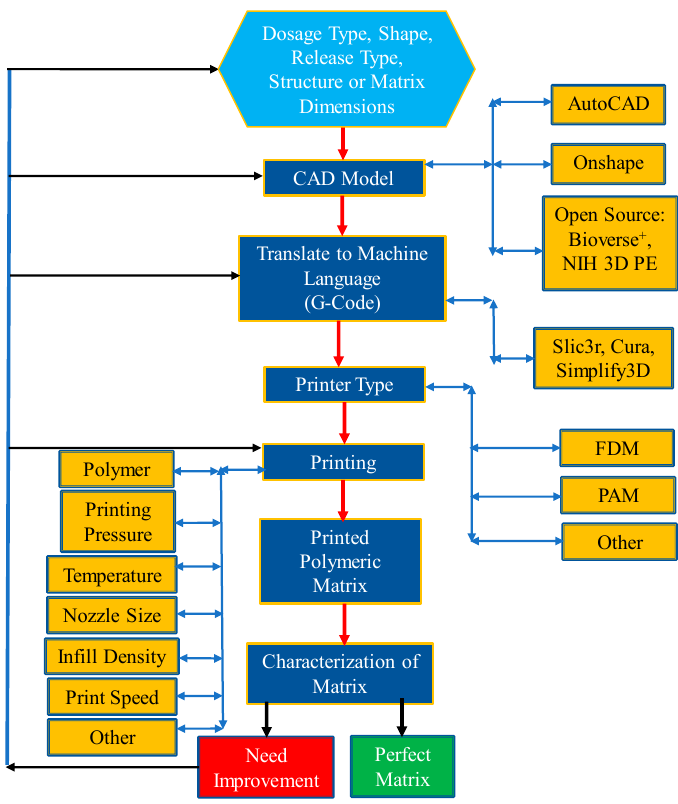
Figure 3. Workflow diagram or decision matrix for a 3D printing process. (CAD: computer-aided design, FDM: fused deposition modeling, PAM: pressure-assisted microsyringe, NIH 3D PE: National Institutes of Health 3D Print Exchange).